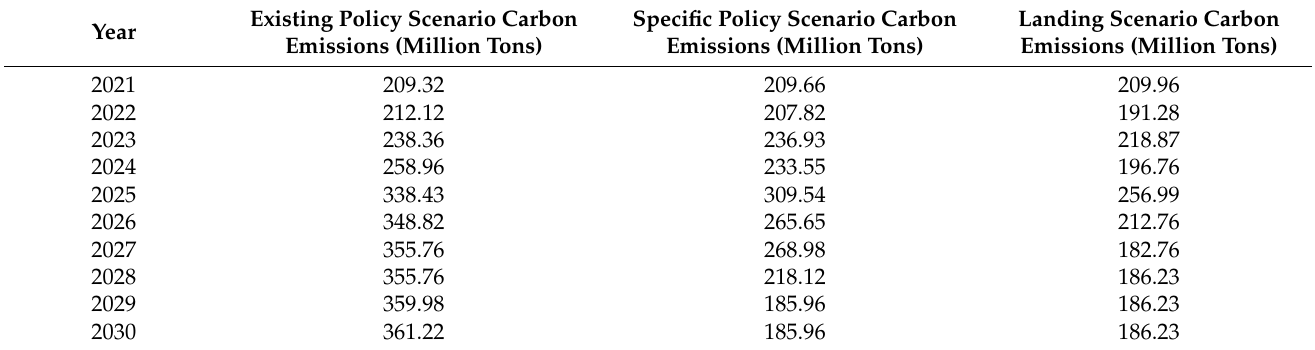
Table 8. CCUS promotion utilization rate in different